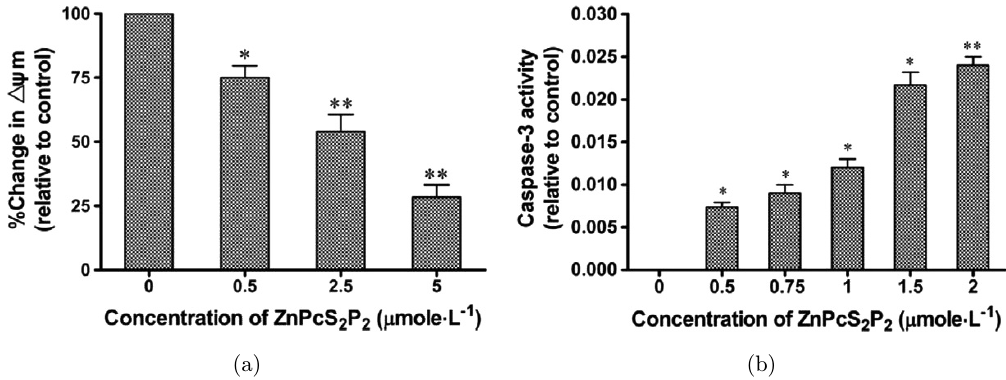
Fig. 6. E®ects of Photocyanine on mitochondrial membrane potential ( (cid:3) m) (a) and caspase-3 activity (b) of HepG2 Cells. Statistical di®erence from controls: * P < 0 : 05; ** P < 0 : 01 ( n ¼ 6). Reproduced with permission from Ref.